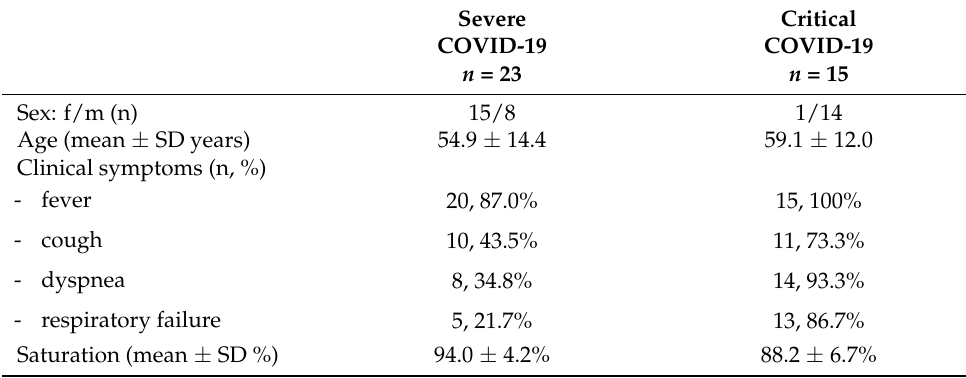
Table 1. Patients’